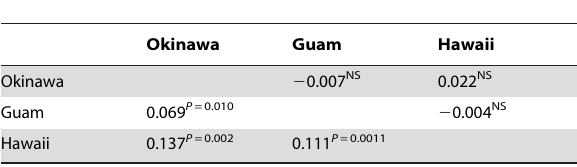
Table 2. Pairwise W ST values among populations of Conus ebraeus estimated from analysis of sequences of conotoxin locus E1 (below diagonal) and mitochondrial COI sequence data (above diagonal).